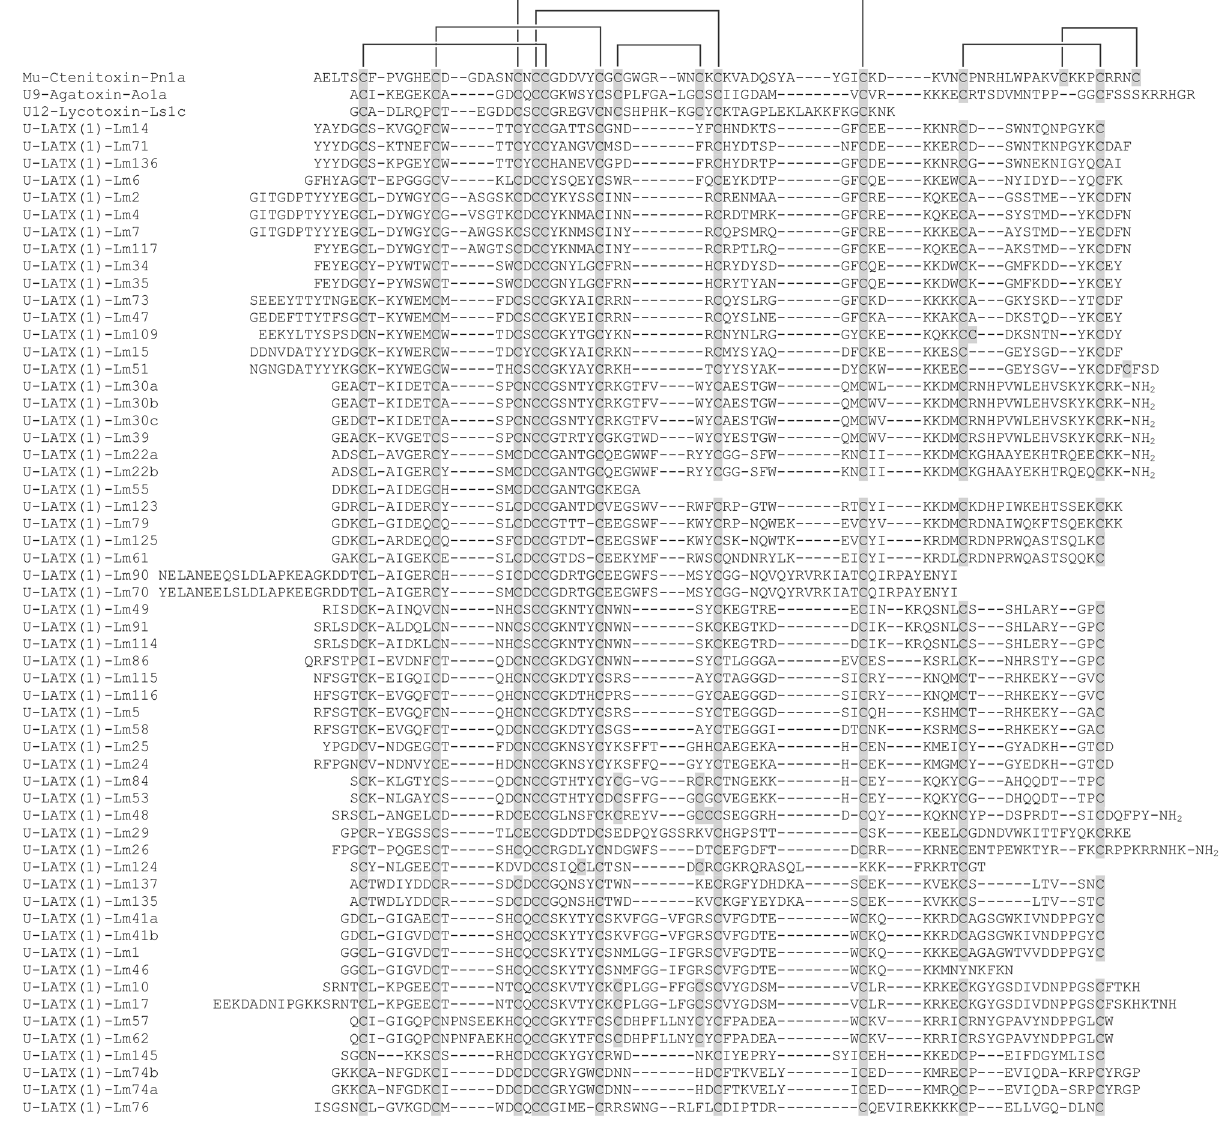
Figure 4. Sequence alignment of peptides in peptide lampotoxin Family 1 and the three closest BLAST matches. Cysteine residues are highlighted in